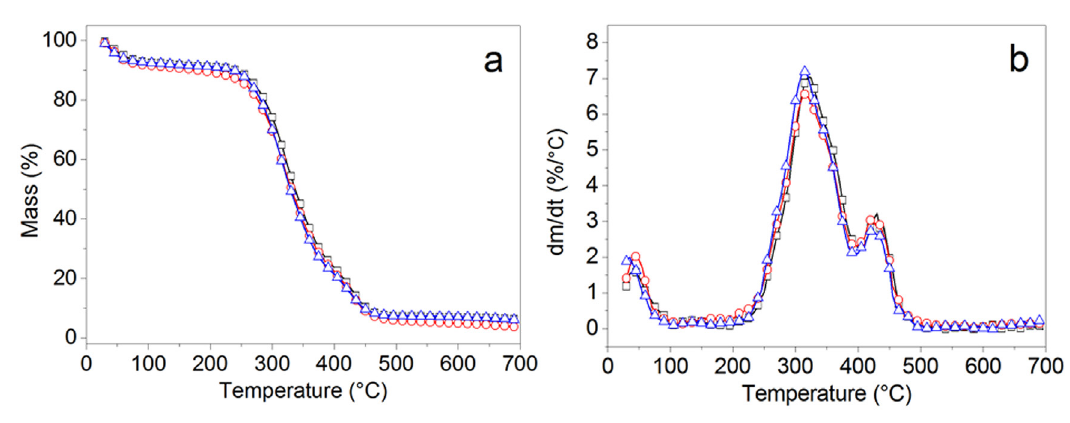
Figure 5. TG (a) and DTG (b) curves for PVA/CS mats at 70:30 (M3, squares), 75:25 (M4, circles), and 85:15 (M6, triangles) compositions.